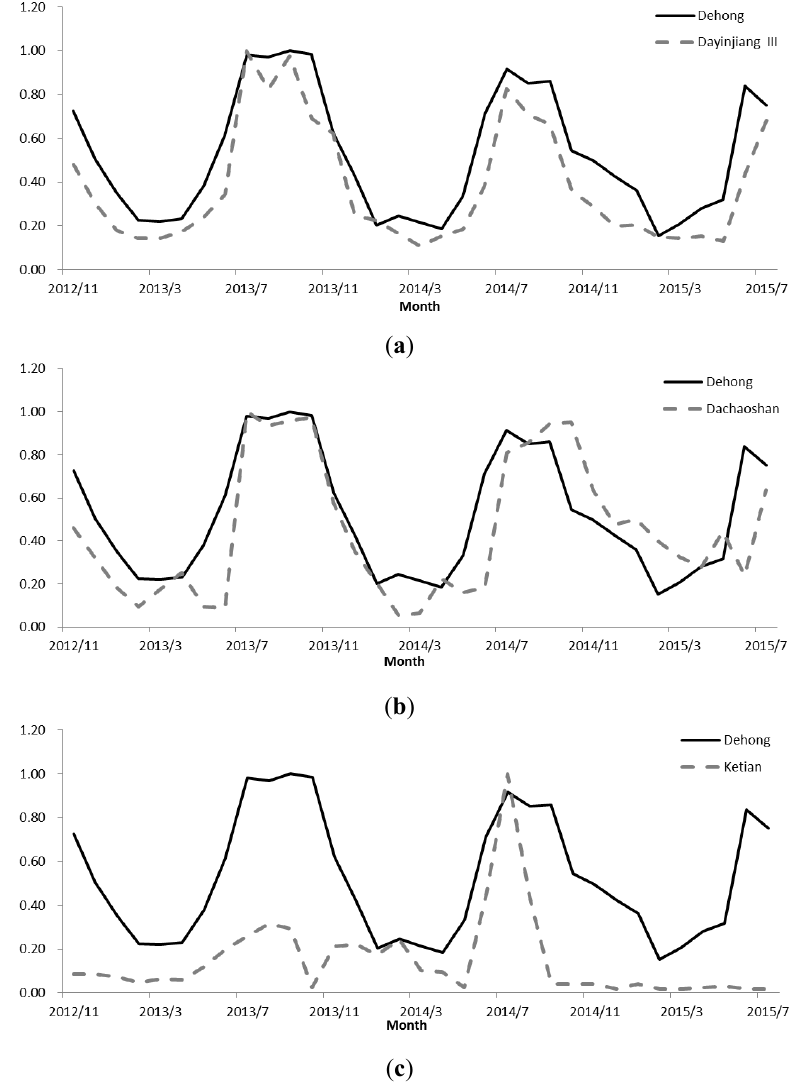
Figure 5. Normalized trend of power production of SHP plants in Dehong and interval flow of the LHP plant. ( a ) Trend Chart of SHP plants in Dehong and Dayingjiang III hydropower plant; ( b ) Trend Chart of SHP plants in Dehong and Dachaoshan hydropower plant; ( c ) Trend Chart of SHP plants in Dehong and Ketian hydropower